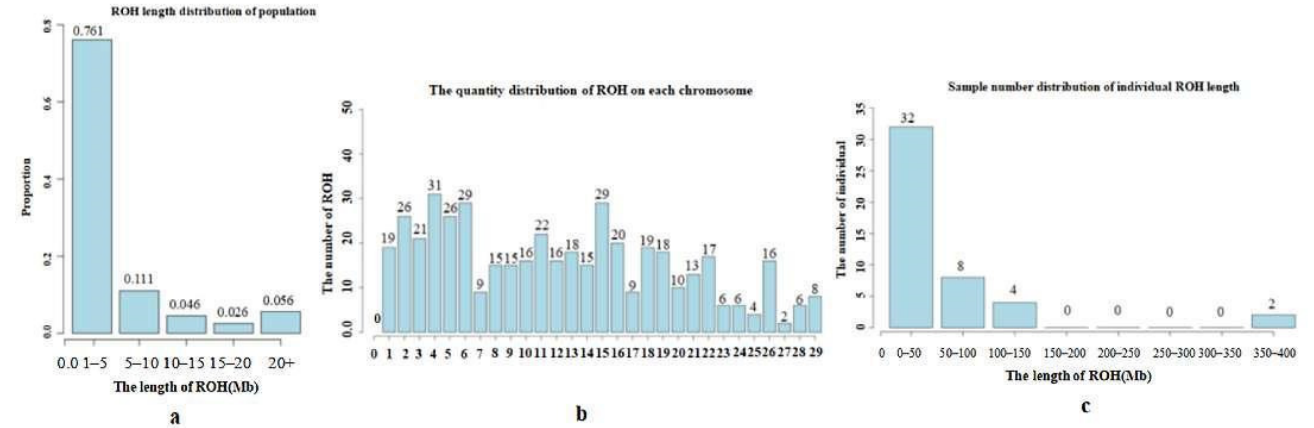
Figure 4. ROH analysis results. Note: ( a ). Distribution of Roh length by population (the abscissa represents the length interval of ROH, and the ordinate represents the population proportion). ( b ). Distribution of the ROH number on each chromosome (the abscissa represents chromosome number, and the ordinate represents ROH quantity). ( c ). Sample number distribution of individual ROH length (the abscissa represents the length interval of Roh, and the ordinate represents the number of individuals).